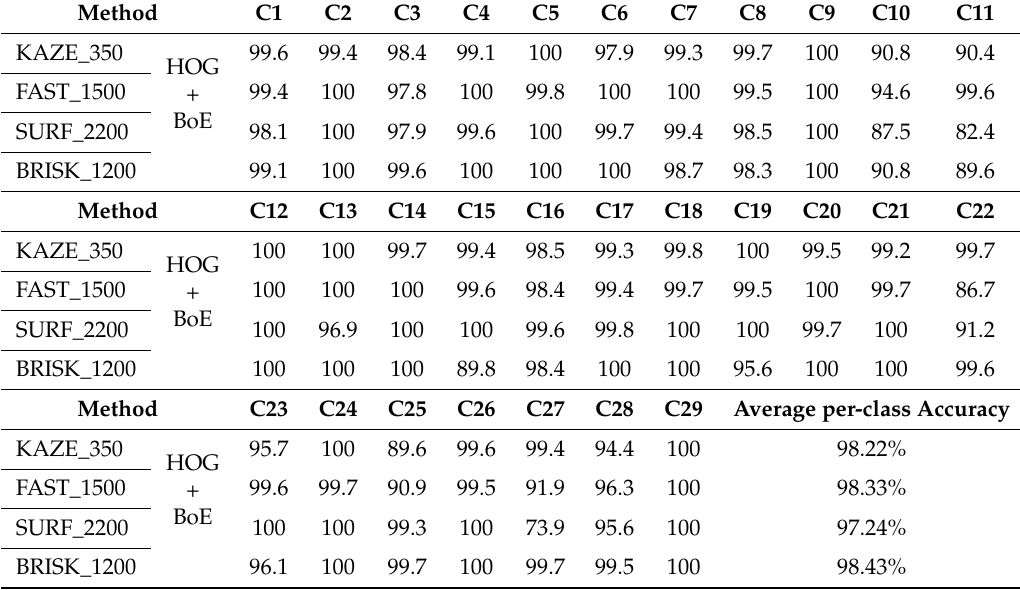
Table 5. The average per-class accuracy of the proposed approaches on the NTOU-MMR dataset. The last column shows the mean average precision of vehicle